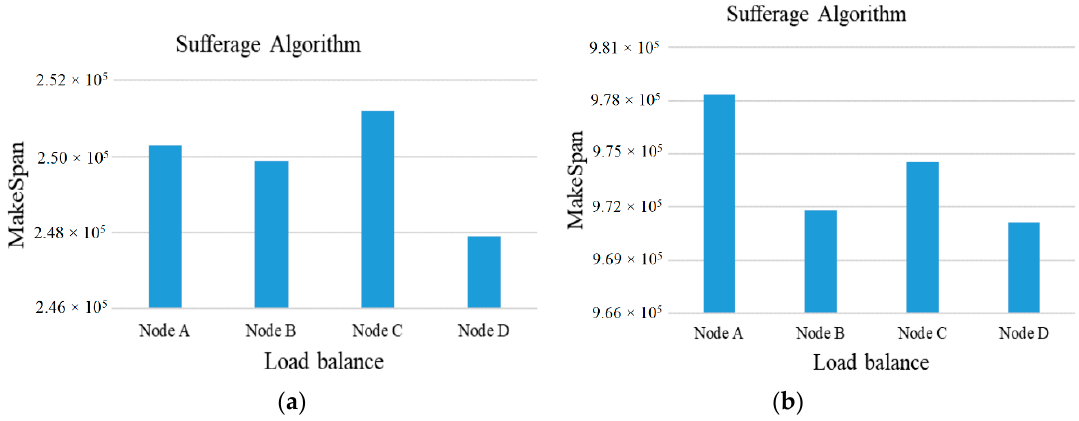
Figure 3. The results of load balancing index in the Sufferage scheduling algorithm for ( a ) n = 4 and number of task = 50 and ( b ) n = 4 and number of tasks = 100.